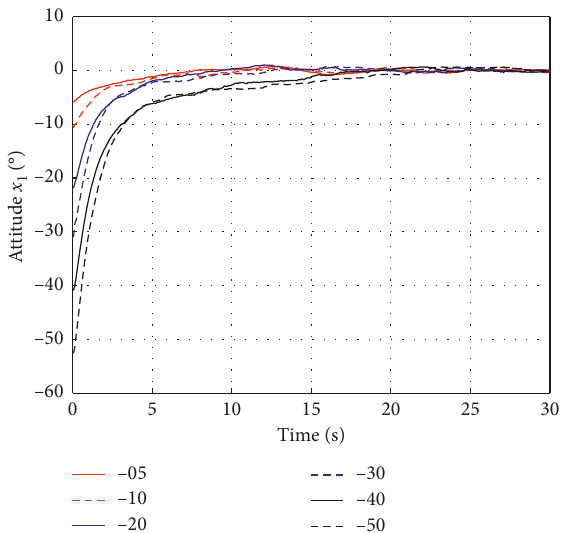
Figure 11: Time response of attitude in M3 under different initial